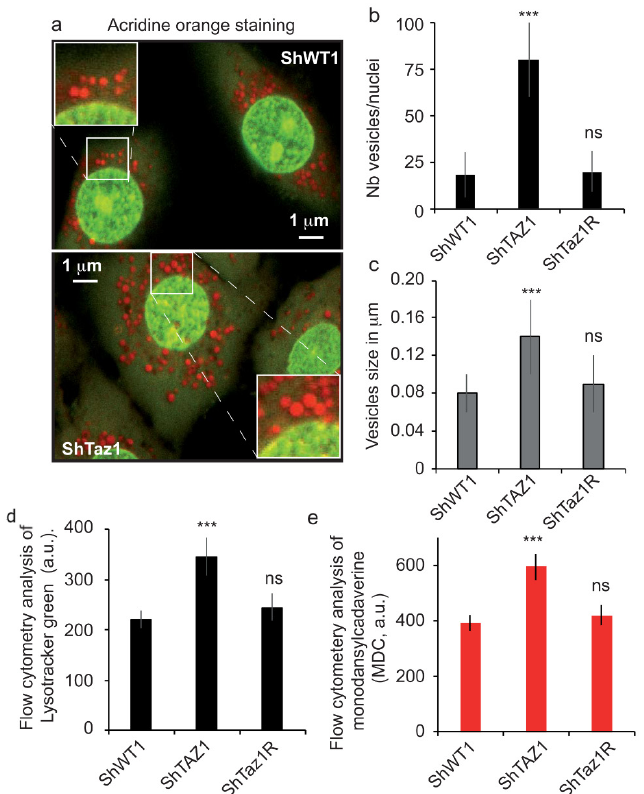
Figure 7. Confocal images and flow cytometry analysis of the acidic vesicles formed in the cytoplasm of control HeLa cells (ShWT1) and tafazzin knockdown cells (ShTaz1). ( a – c ) Analysis of the three HeLa cell lines (ShWT1, ShTaz1 and ShTaz1R) stained with AO. ( a ) Acridine orange staining of the lysosomes and other acidic compartments. At the top, ShWT1 control cells and bottom, ShTaz1 tafazzin knockdown. ( b ) Histogram representation of the number of red vesicles per nucleus. Calculation from 10–20 image field as presented in Figure 6a,b. ( c ) Histogram representation of vesicle size in µ M calculated in the same image fields as presented in Figure 6a,b. ( d ) Flow cytometry analysis of the accumulation of LysoTracker Green in arbitrary units (a.u.). ( e ) Flow cytometry analysis of staining by monodansylcadaverine (MDC, in arbitrary units). ns = no significant and *** is the p -value ≤ 0.001.